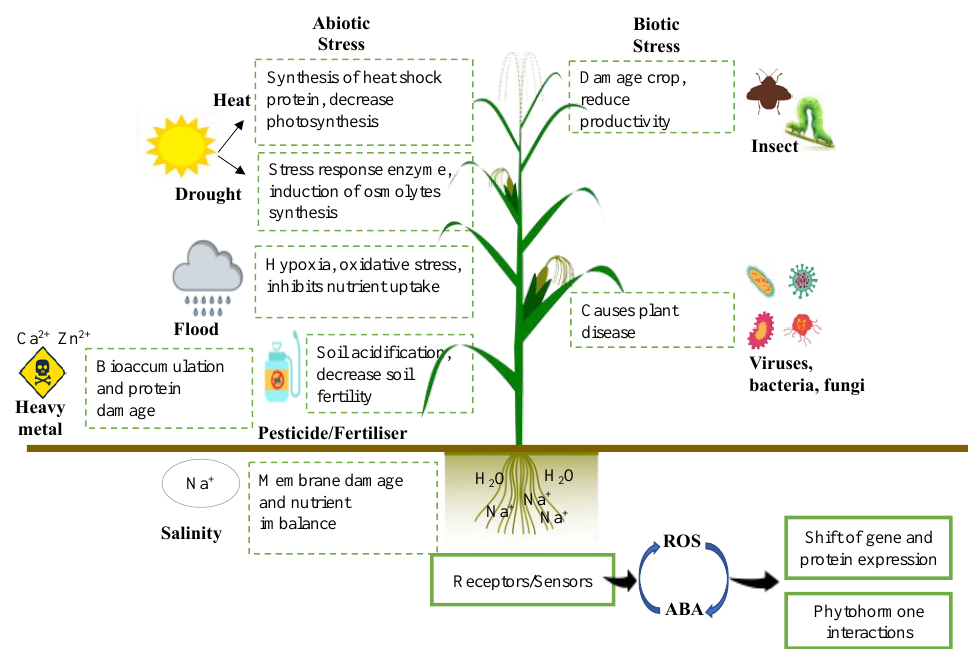
Figure 3. The effects of abiotic and biotic stresses on crop productivity.